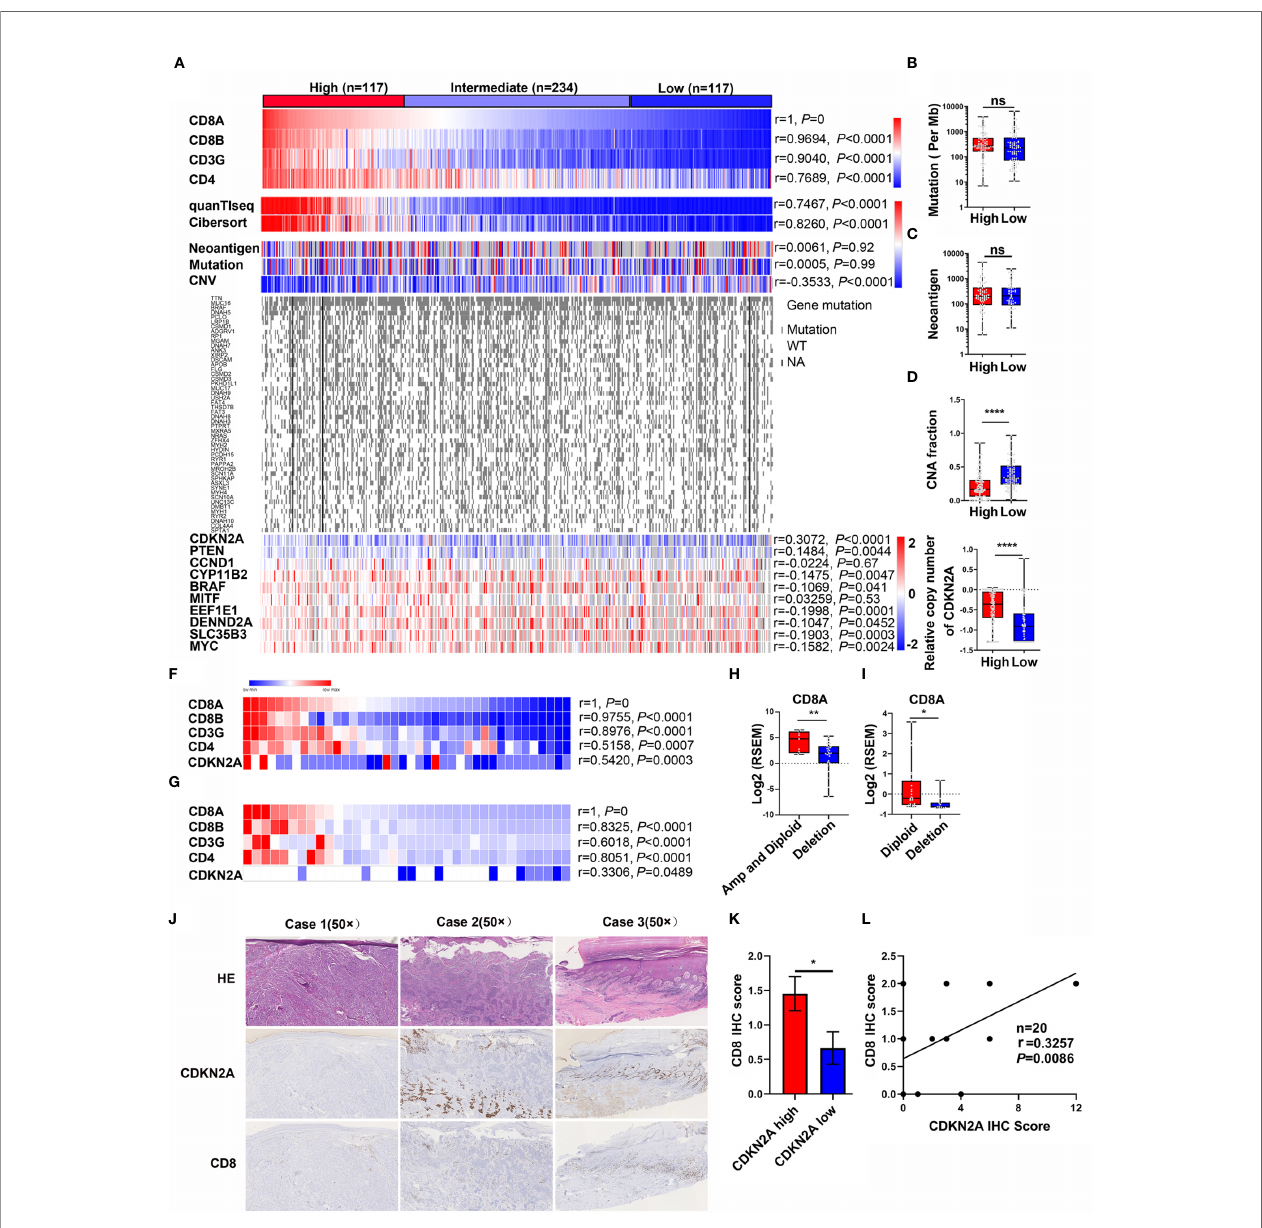
FIGURE 1 | Discovery of the genetic events correlated with CD8+ T cell in fi ltration in melanoma. (A) Heatmap of T cell marker expression, CD8+ T cell score, the genetic events, the top 50 genes with the highest mutation rate, and the top 10 genes with the highest copy number alteration in TCGA-melanoma cohort. Pearson correlation analysis between CD8A expression and other T cell marker expression, CD8+ T cell score, genetic events, top 10 genes with the highest copy number alteration were also analyzed. (B – E) The difference of mutation (B) , neoantigen (C) , CNA fraction (D) , and CDKN2A copy number (E) in CD8A High and Low subgroups. (F) Heatmap of CD8+ T cell marker expression and CDKN2A copy number in DFCI cohort (n = 40). Pearson correlation analysis indicated that the copy number of CDKN2A is positively associated with CD8+ T cell marker expression. (G) Heatmap of CD8+ T cell marker expression and CDKN2A copy number in TGEN cohort (n = 36). Pearson correlation analysis indicated that the copy number of CDKN2A is positively associated with CD8+ T cell marker expression. (H) CD8A expression in melanoma patients with diploid and ampli fi cated CDKN2A (n = 9) compared with patients with CDKN2A deletion (n = 31) (DFCI cohort). RSEM, RNA-Seq by Expectation-Maximization. (I) CD8A expression in melanoma patients with diploid or ampli fi cated CDKN2A (n = 24) compared with patients with CDKN2A deletion (n = 12) (TGEN cohort). RSEM, RNA-Seq by Expectation-Maximization. (J) The representative IHC analysis of CDKN2A and CD8 expression in melanoma patients. (Case 1: Invasive melanoma with negative CDKN2A expression and few CD8-positive lymphocytes. Case 2: Invasive melanoma with positive CDKN2A expression in the deep dermis, but loss of CDKN2A expression in the upper dermal component, while few CD8-positive lymphocytes in the upper dermal tumor tissue and relatively high CD8-positive lymphocytes in the deep dermis. Case 3: melanoma in situ with positive CDKN2A expression, while abundant CD8-positive lymphocytes in the papillary layer of dermis.) (K) The difference between the IHC score of CD8 in the melanoma patients with low CDKN2A expression (IHC score: 0~2) or high CDKN2A expression (IHC score: 3~12). (L) The pearson correlation coef fi cient analysis of CDKN2A and CD8 expression in 20 melanoma patients. *p < 0.05, **p < 0.01, ****P < 0.0001, ns, not signi fi